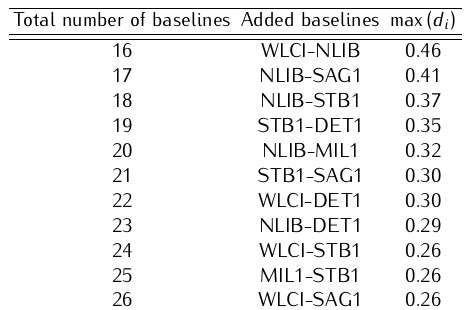
Table 2. The 11 baselines with the highest contribution to network robustness. Baselines are added one by one and as the